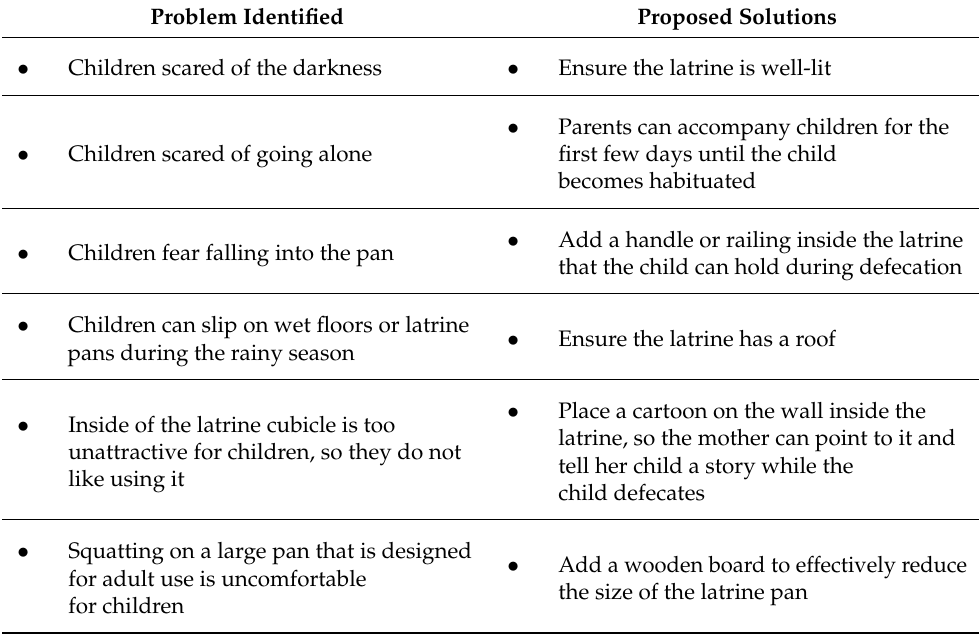
Table 2. Key findings from the focus